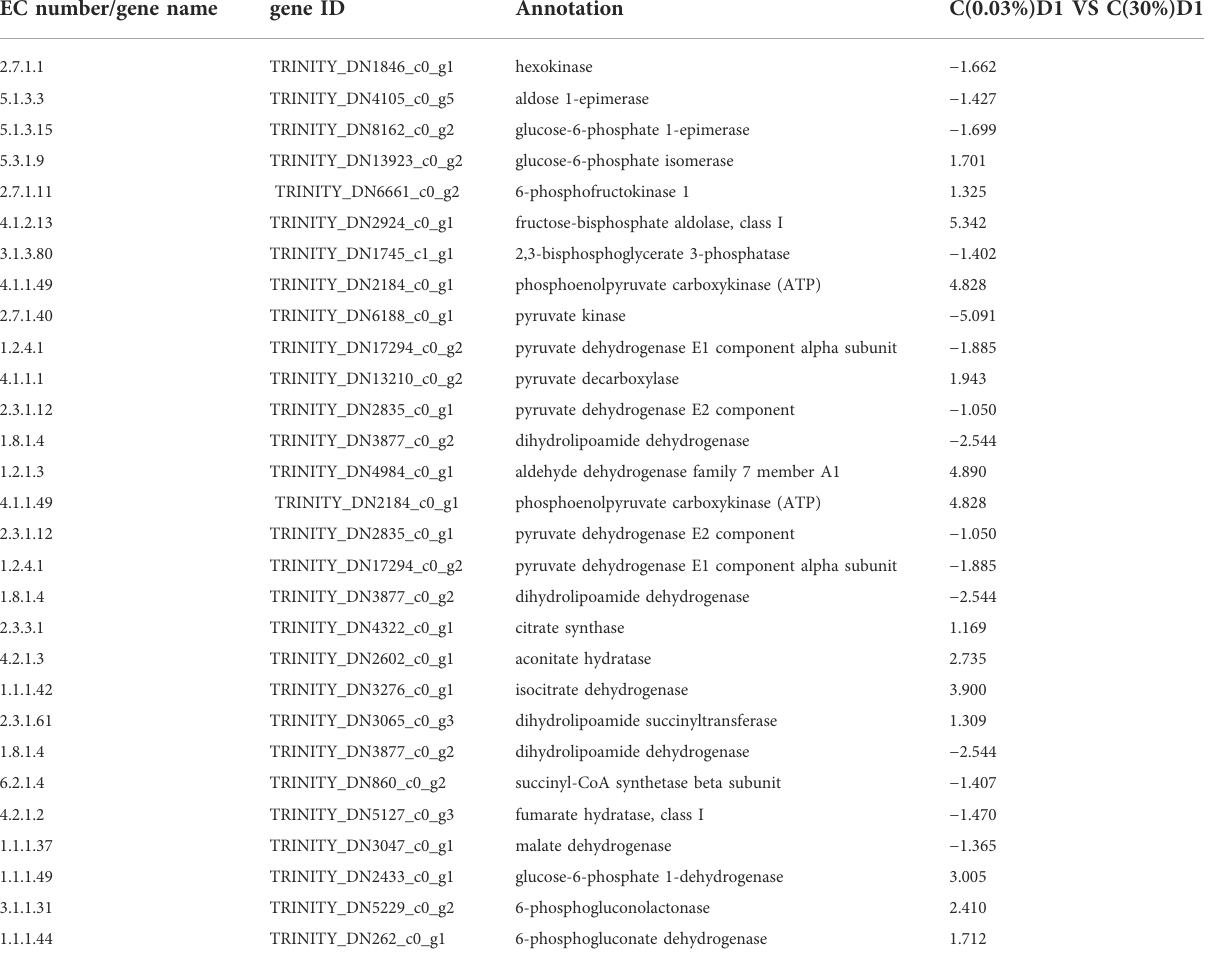
TABLE 2 Differential expression of key proteins in central carbon